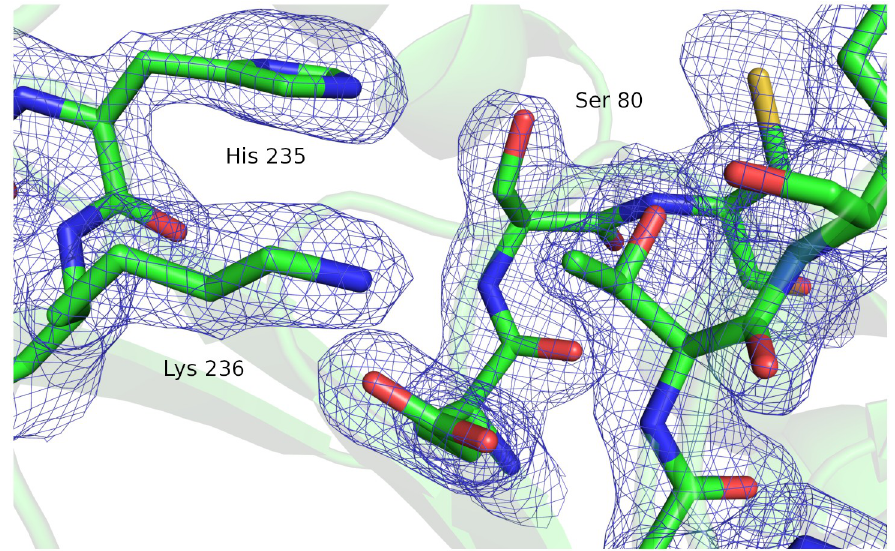
Fig 3. The active site of HNL1 showing electron density (2Fo − Fc) contoured at 1 σ . The labels mark serine 80 and histidine 235 from the catalytic triad and the catalytically essential lysine 236.